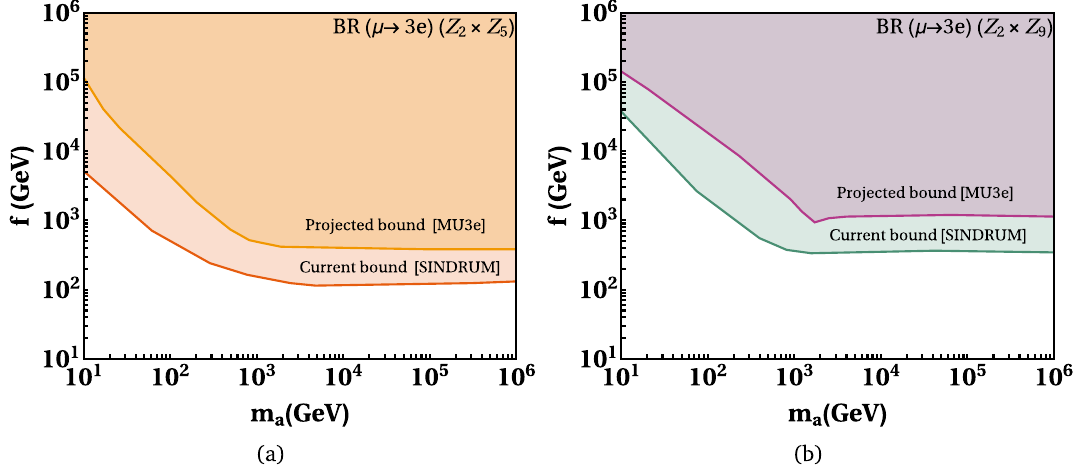
Fig. 13 The left panel represents the allowed parameter space by BR (μ → e ) conversion in the m a − f plane with different experi- mental limits of various target nuclei in Table 9 with λ χ = 2, for the